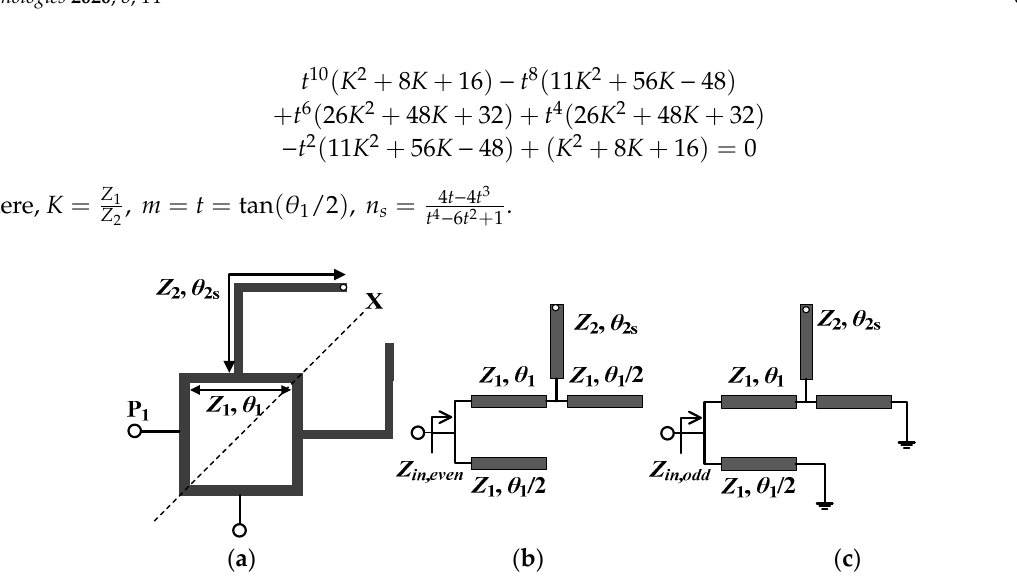
Figure 6. ( a ) Square ring resonator with λ g /2 short- ended stubs, ( b ) Even-mode equivalent circuit, ( c ) Odd-mode equivalent circuit.